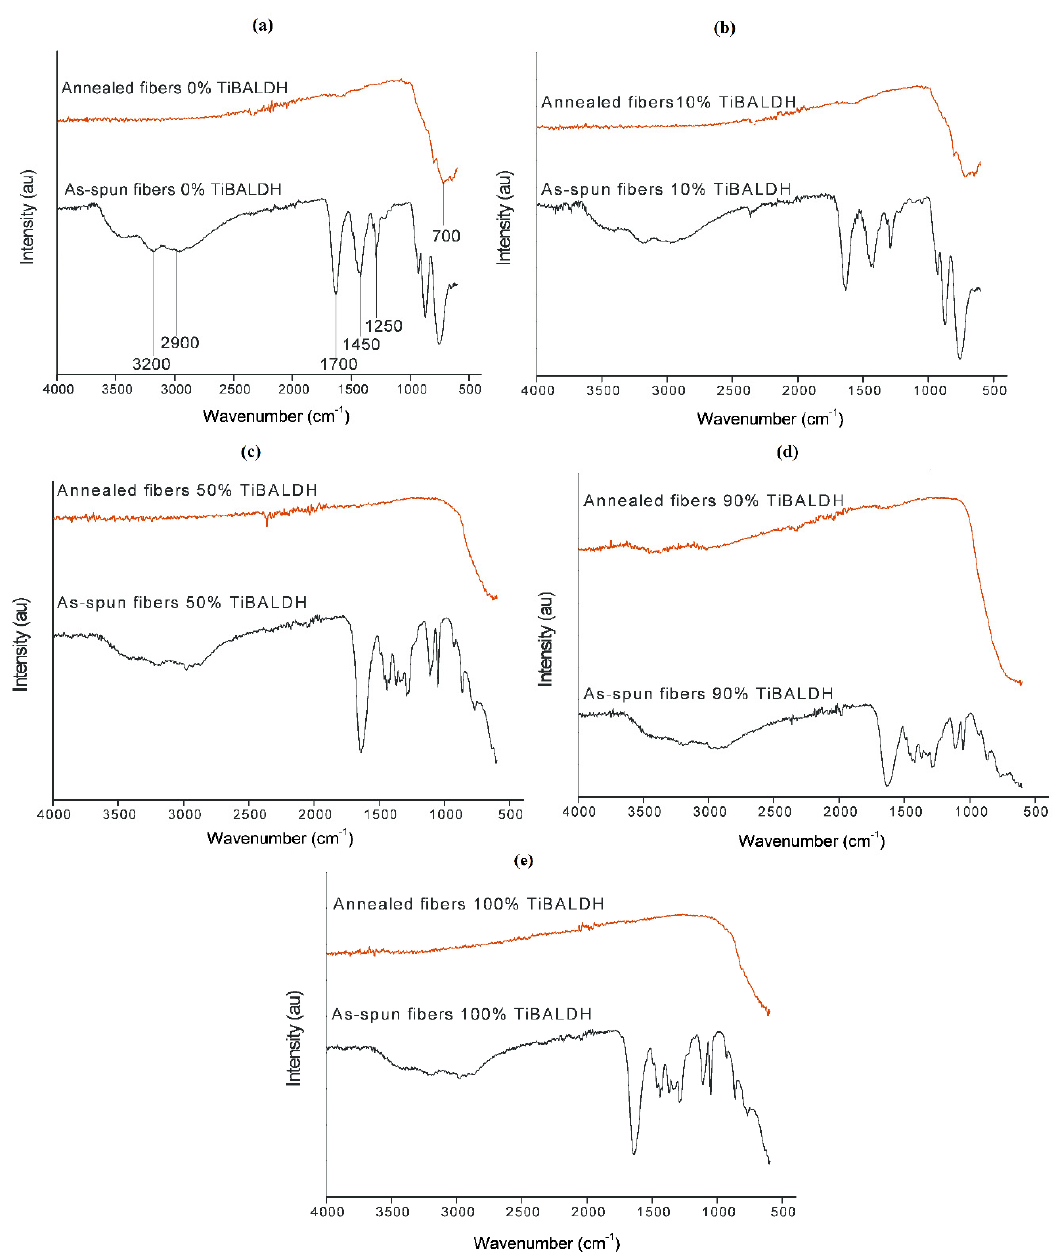
Figure 4. FTIR spectra of as-spun and annealed fibers: ( a ) 0% TiBALDH, ( b ) 10% TiBALDH, ( c ) 50% TiBALDH, ( d ) 90% TiBALDH and ( e ) 100% TiBALDH.